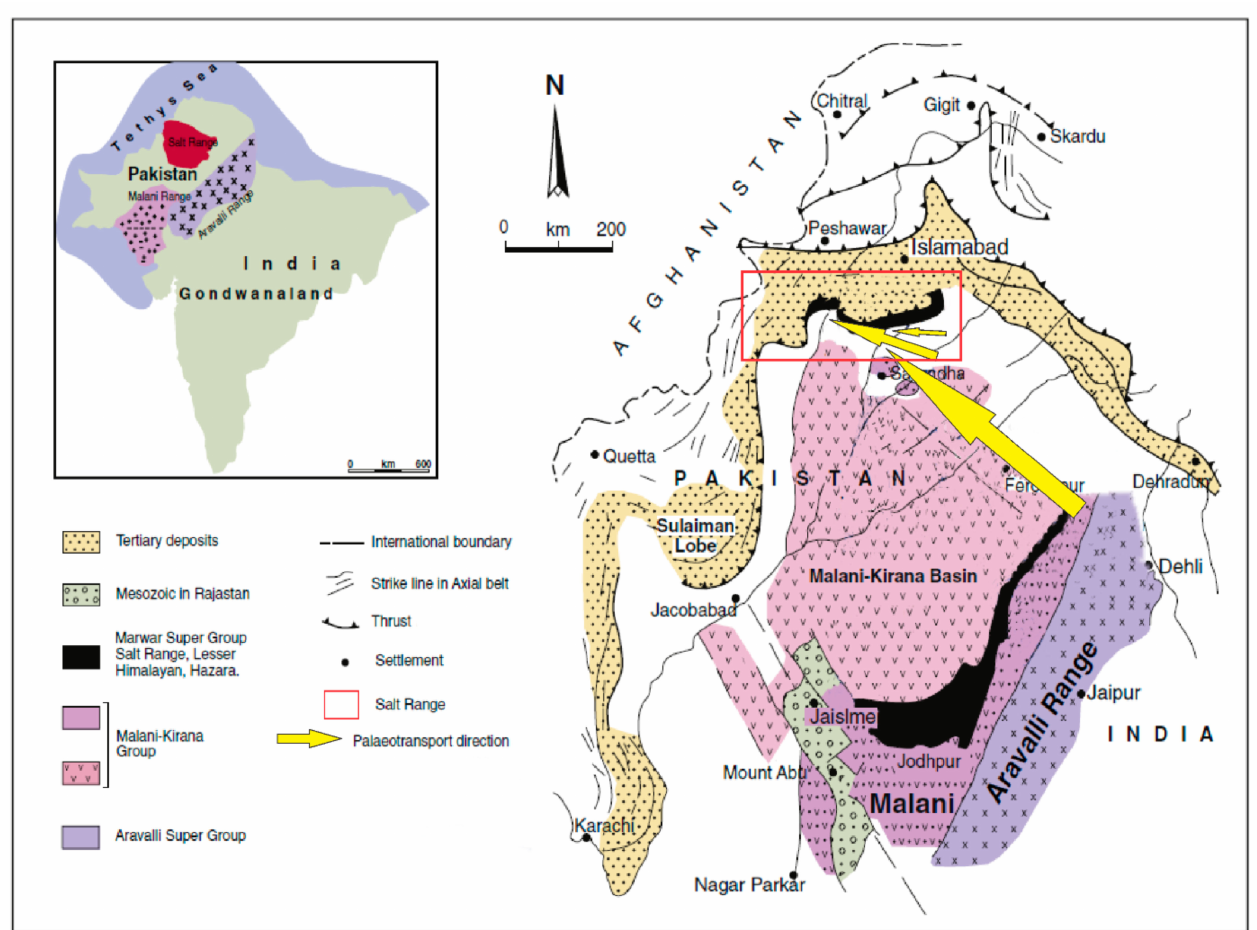
Figure 18. A generalised geological map of foreland Pakistan and adjoining northwest India showing the Salt Range and the possible source areas of the siliciclastics for the Upper Triassic–Lower Jurassic siliciclastics of the Kingriali and Datta formations (modified from